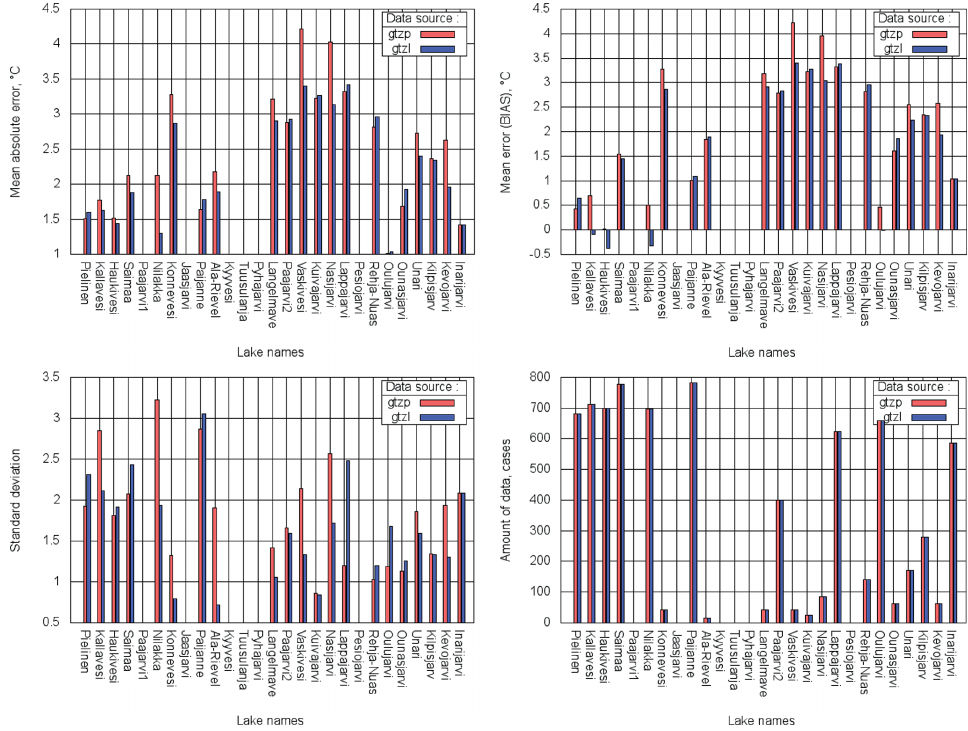
Figure 17. Same as Fig. 14 but calculated over all stratified summer